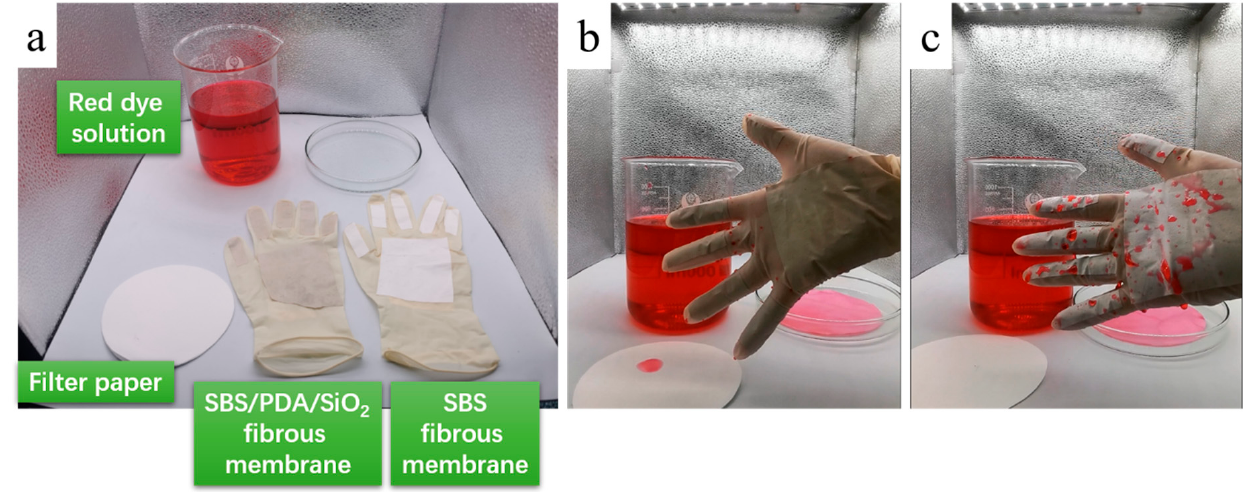
Figure 13. ( a ) The SBS and SBS/PDA/SiO 2 fibrous membrane modified gloves, ( b ) the SBS/PDA/SiO 2 fibrous membrane modified glove after immersion in a red dye solution, and ( c ) the SBS fibrous membrane modified glove after immersion in a red dye solution.